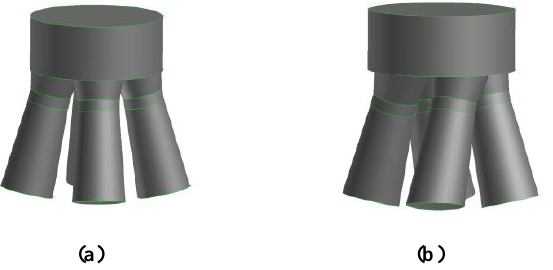
Figure 3. Schematic diagram of different oxygen lance nozzles. ( a ) conventional oxygen lance, ( b ) nozzle-twisted oxygen lance.